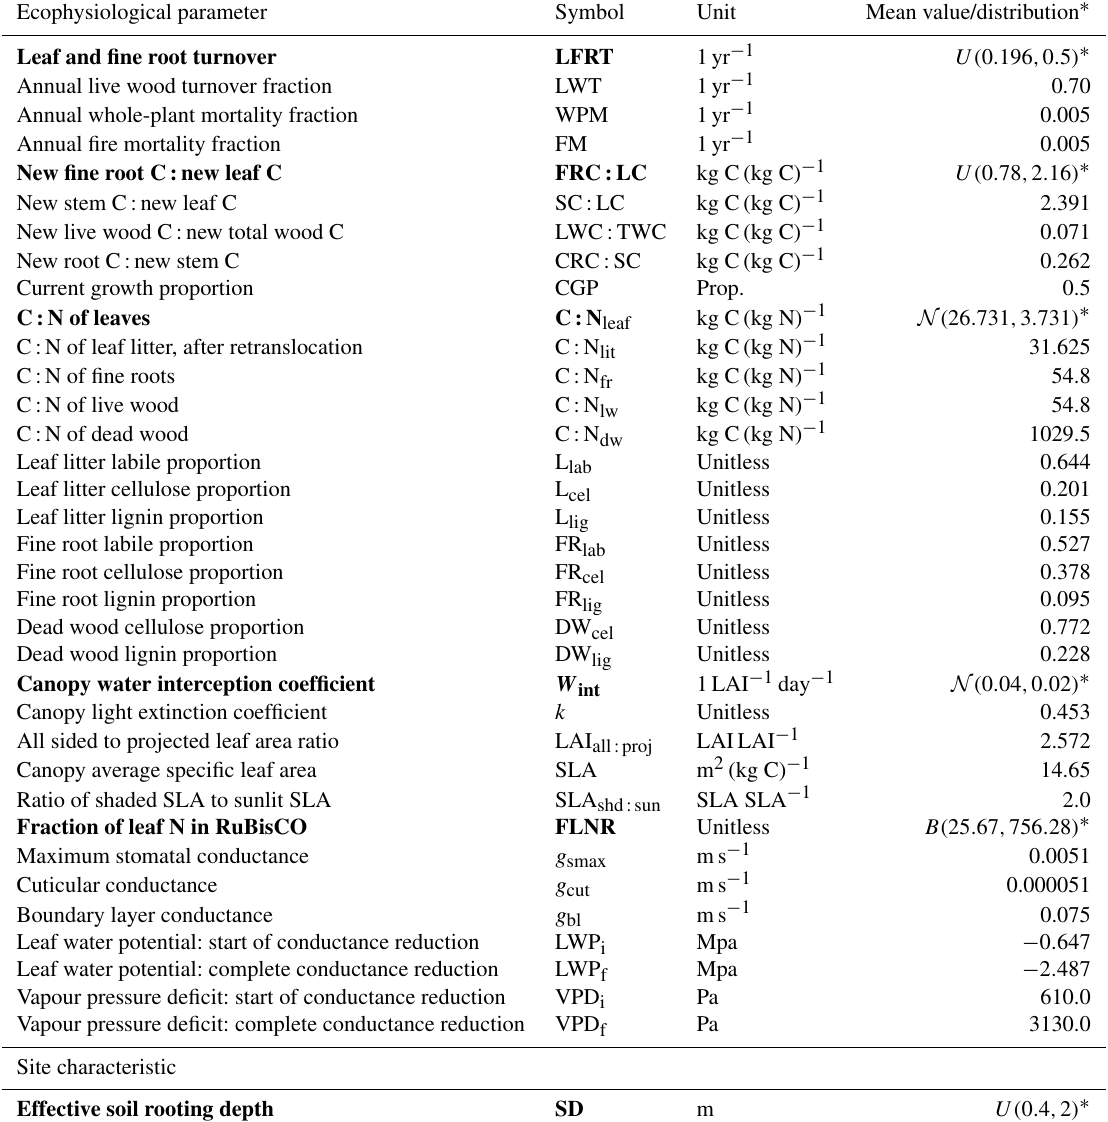
Table 1. The 35 ecophysiological parameters needed to run Biome-BGC for Douglas fir (evergreen needleleaf species). Mean val- ues/distributions were taken from Raj et al. (2014). The ecophysiological parameters highlighted in bold and the effective soil rooting depth were included in a Bayesian